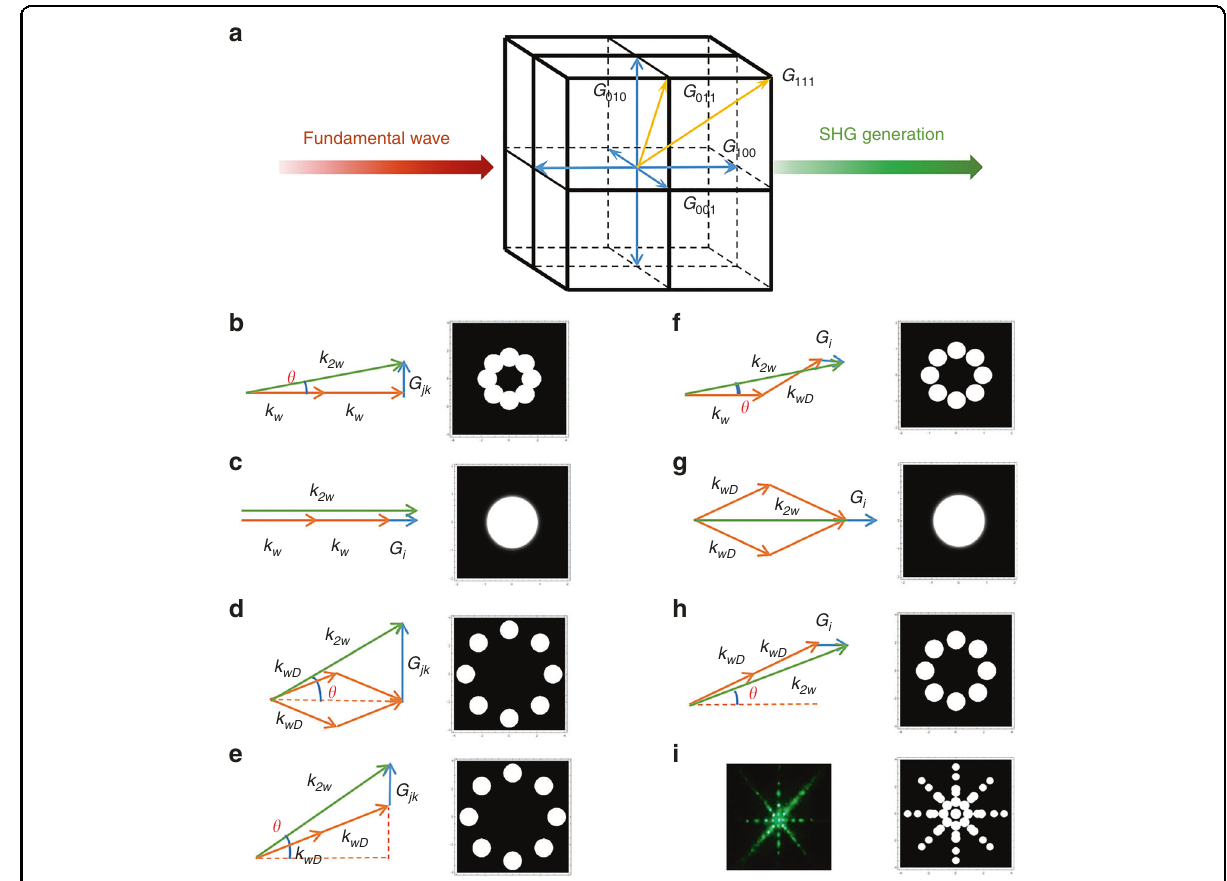
Fig. 3 SHG spots from a 3D KTN crystal generated experimentally and by simulation. a Schematic of the 3D RLVs in the KTN crystal. b SHG spots produced by Raman – Nash diffraction of the 2D QPM. c SHG spots produced by collinear QPM. d , e SHG spots from the QPM produced by the interaction between the fundamental diffraction wave and 2D RLVs in the y – z plane. f – h SHG spots from the QPM produced by the interaction between the fundamental diffraction wave and RLV along the x -axis. i Comparison between the simulated and experimental